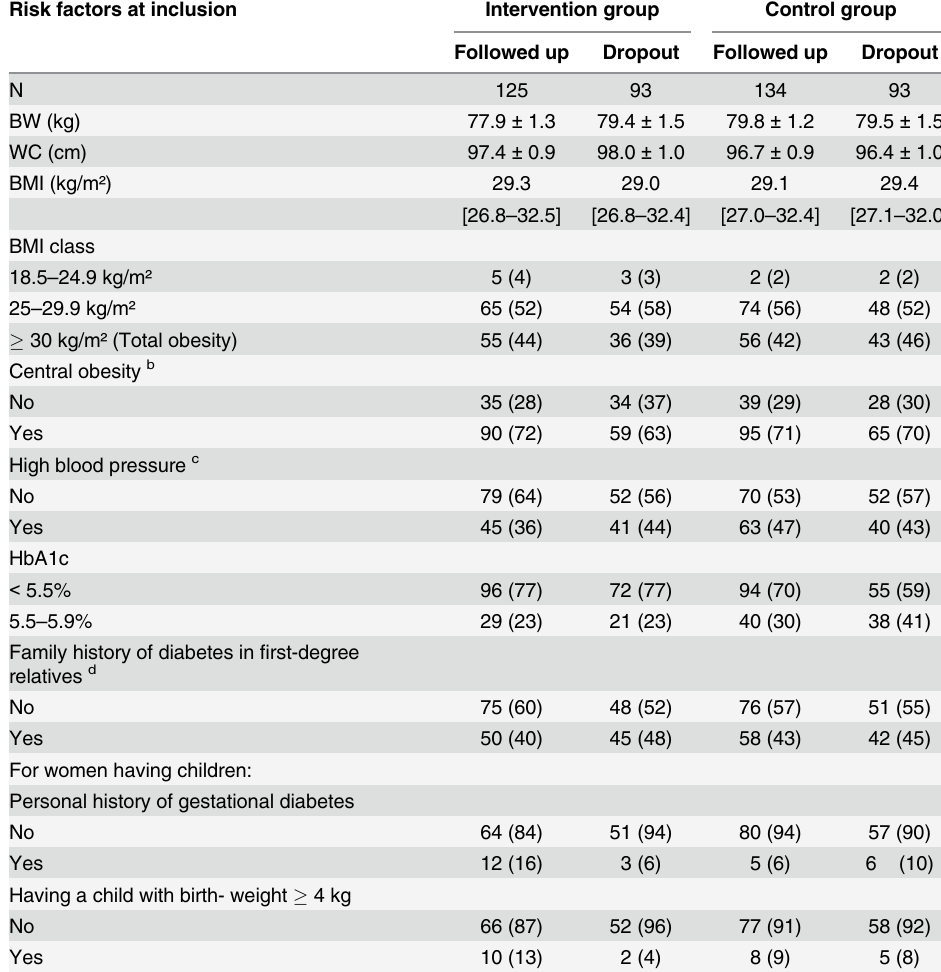
b based on WC using two gender speci fi c cut-off, 90 cm for women, 100 cm for men. c treated or screened if not treated (blood pressures (cid:1) 140/90 mm Hg). d father / mother / brother / sister /